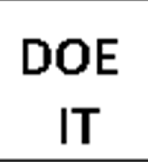
Figure 5. Watermark. Figure 5.